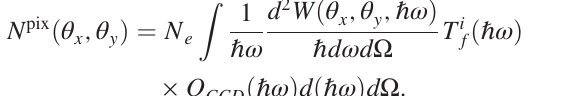
TABLE I. Filter characteristics. No.